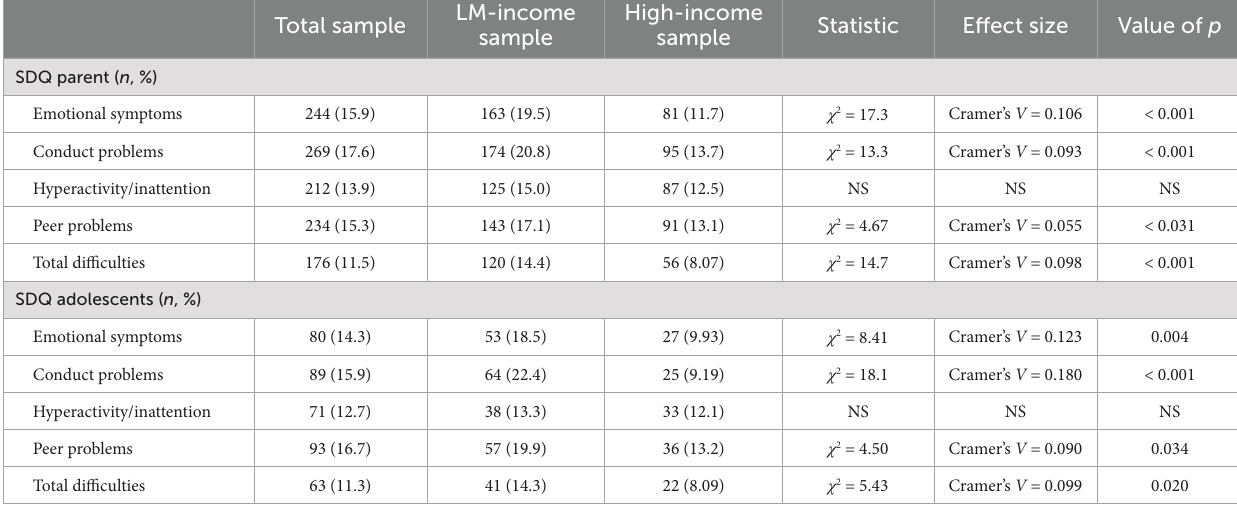
TABLE 2 Clinically relevant cases according to the parent- and adolescent-reported